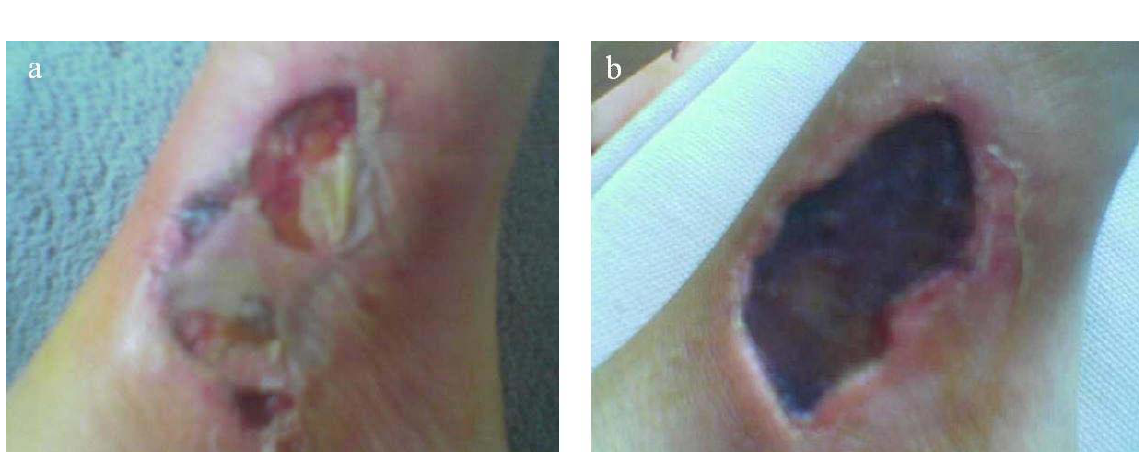
Figure 3. The necrotic superficial dermal tissue was debrided, the wound exhibited purulent material (a) and formation of the necrosis (b).